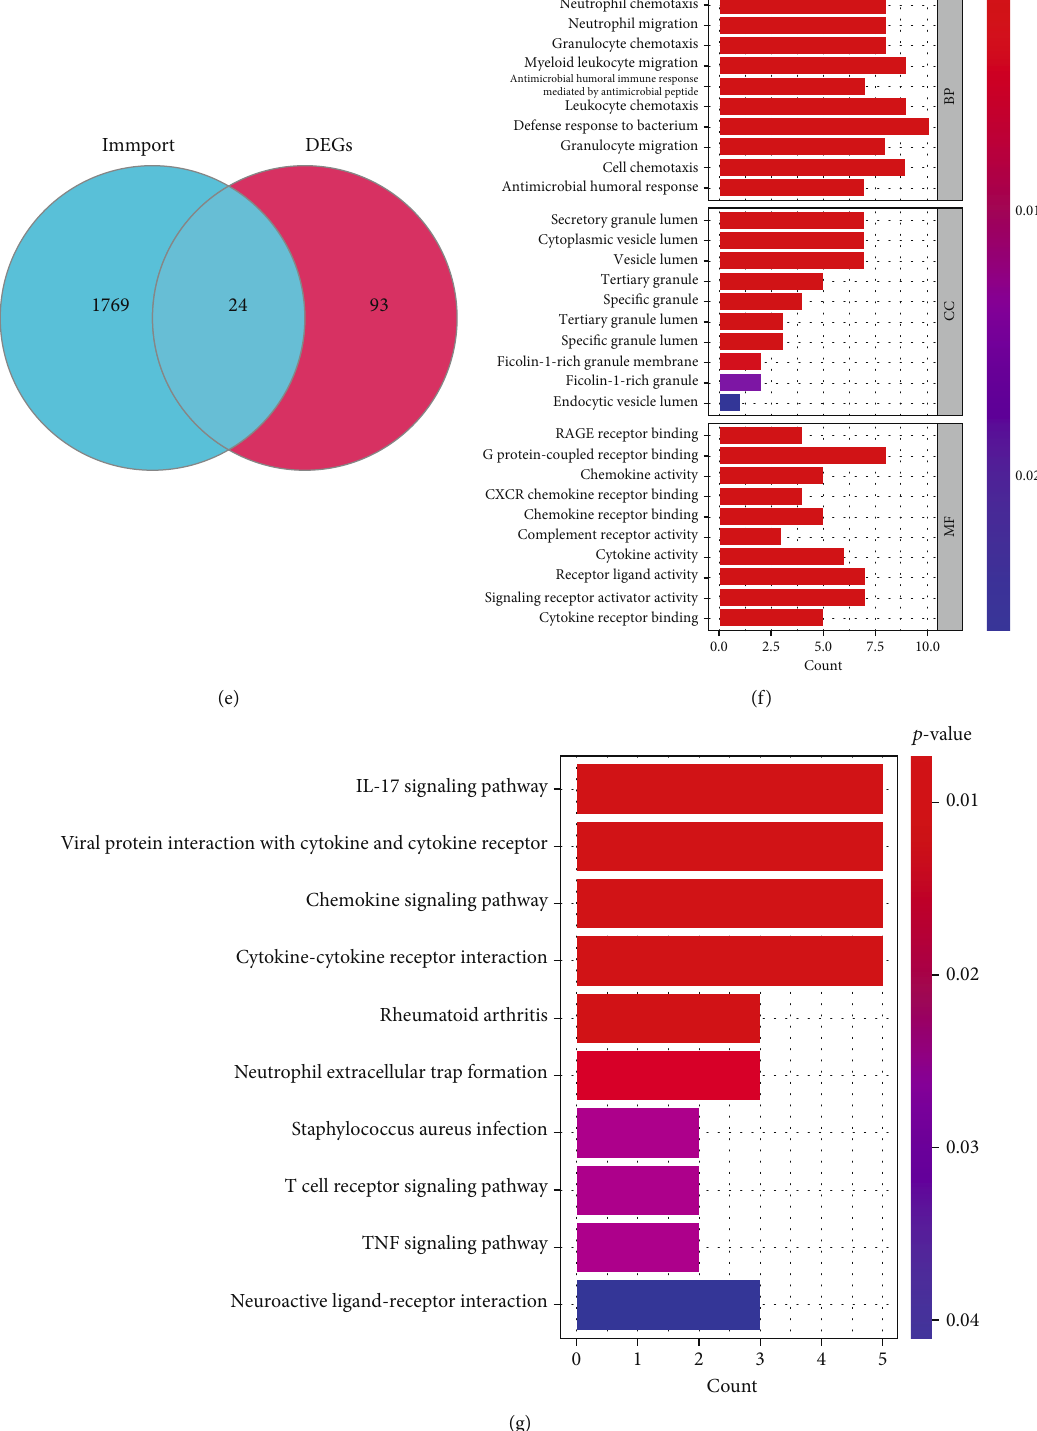
Figure 1: Identi fi cation of immune-related IIC-DEGs based on the combined GEO datasets. (a) The upper PCA plot performs the combined gene expression datasets of GSE11783, GSE11839, GSE28242, and GSE57560. The lower PCA plot performs the combined gene expression datasets of GSE11783, GSE11839, GSE28242, and GSE57560 after removing batch e ff ects. (b) Abundance of 28 in fi ltrated immune cells evaluated by ssGSEA for IC cohort and normal control cohort. (c) The heatmap performs the di ff erentially expressed genes between the IC cohort and normal control cohort. (d) The volcano plot shows the detailed information of the IC-DEGs. (e) The Venn diagram performs the intersection genes between IC-DEGs and immune-related genes. (f) GO enrichment analysis based on the immune-related IC-DEGs. (g) KEGG enrichment analysis based on the immune-related